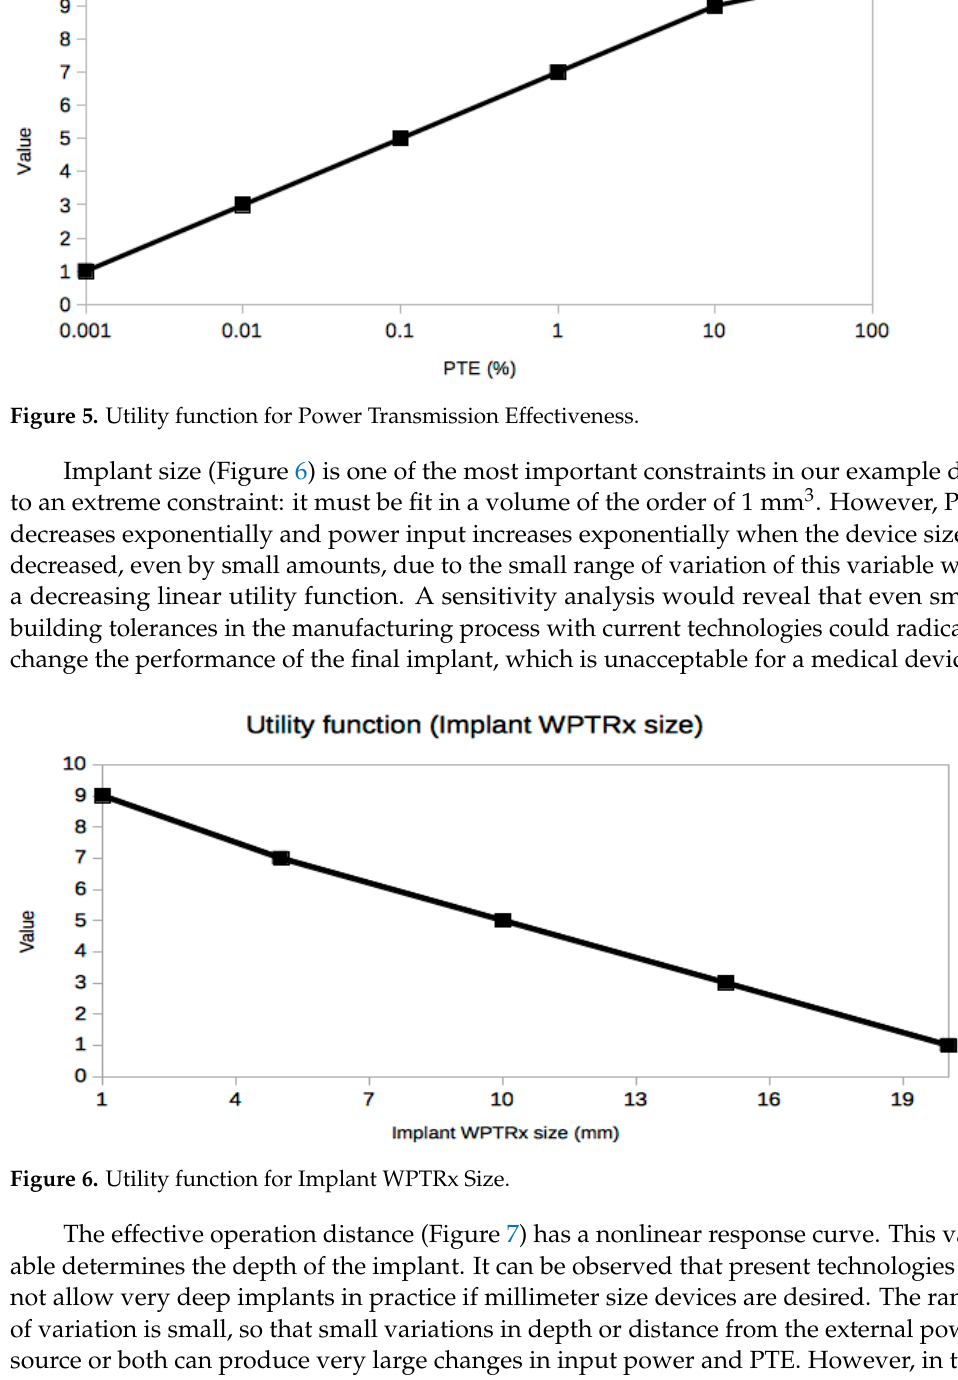
Figure 6. Utility function for Implant WPTRx Size.